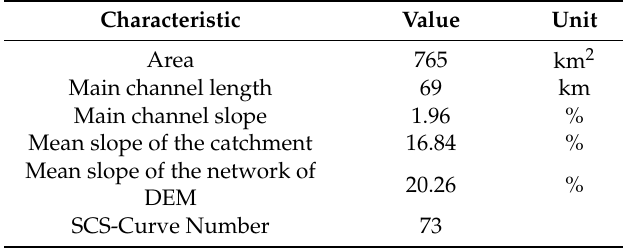
Table 1. Main characteristics of the Alcanadre catchment.